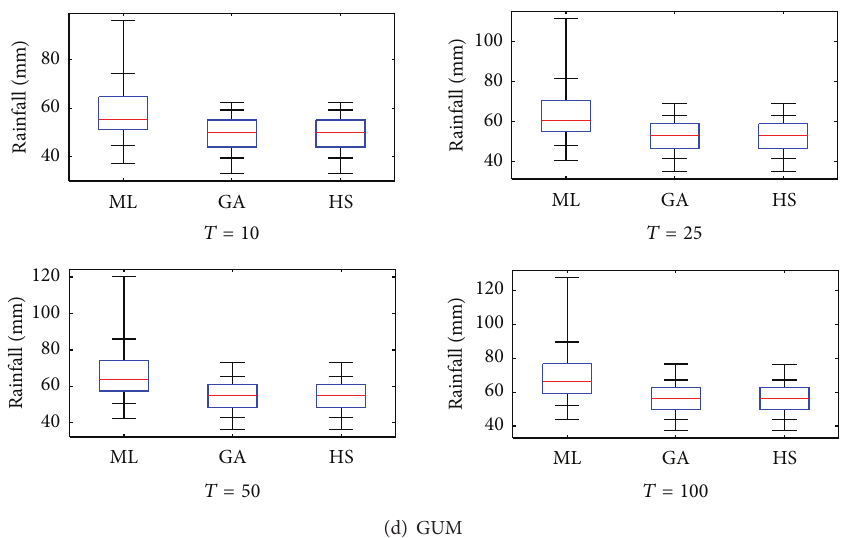
Figure 7: Quantiles using four PDMs at 74 stations in Republic of Korea. (a) LN2, (b) GAM2, (c) GEV, and (d) GUM.